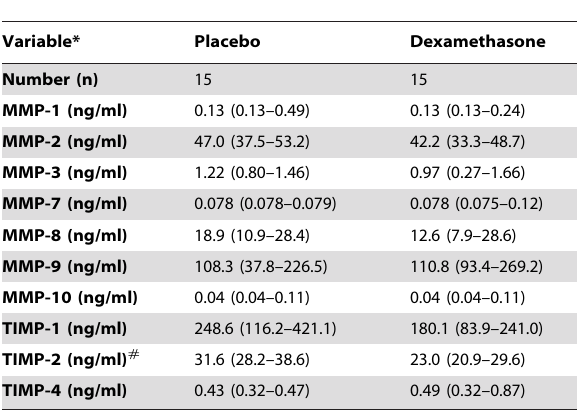
Table 2. Baseline CSF MMP/TIMP concentrations. Variable*